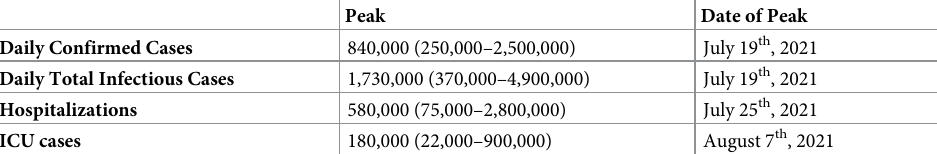
Table 1. Forecasted peaks and dates of peak daily confirmed cases, total infectious cases, hospitalizations, and ICU cases, given current vaccination and social distancing measures. 90% confidence intervals are given in